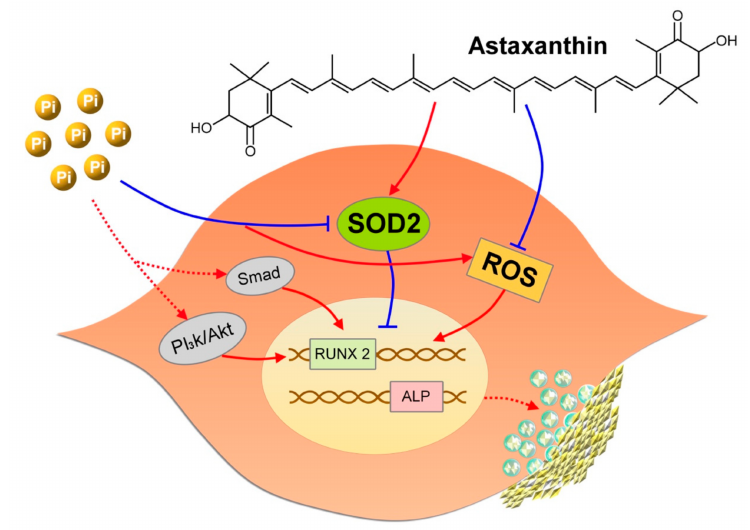
Figure 7. A graphical illustration of findings in this study. ALP, alkaline phosphatase; Pi, inorganic phosphate; ROS, reactive oxygen species; SOD2, superoxide dismutase